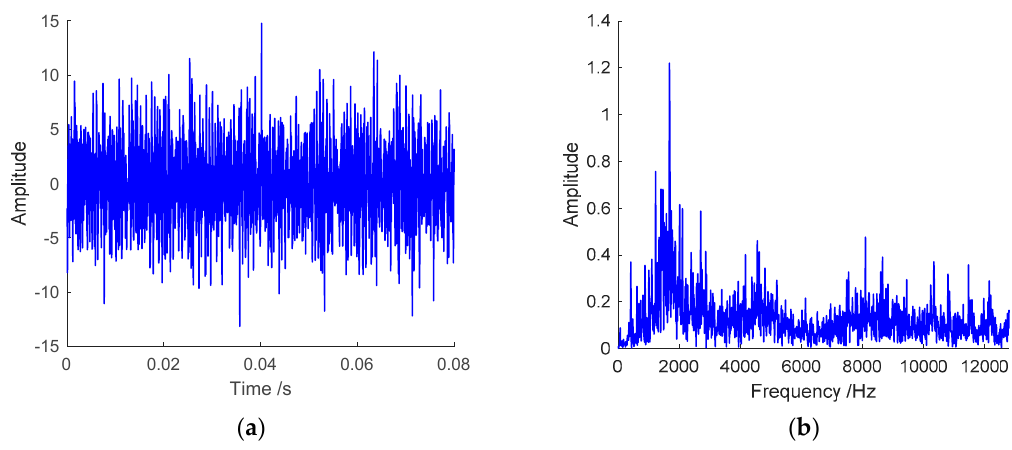
Figure 22. The original signal for further analysis: ( a ) Waveform; ( b ) frequency spectrum.